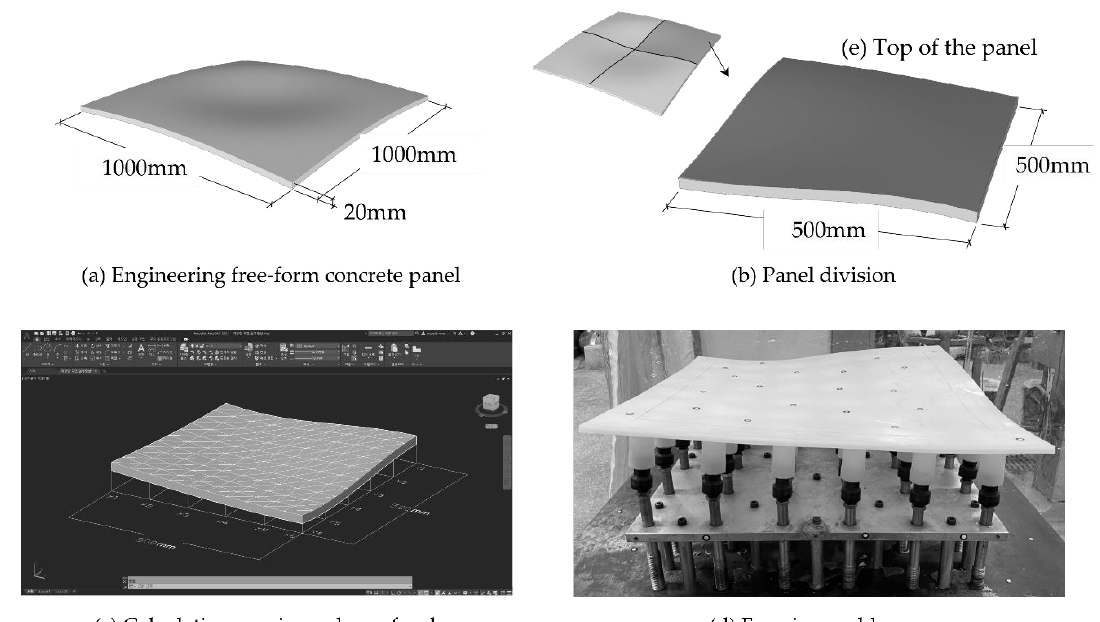
Figure 10. Shape engineering and curve forming.